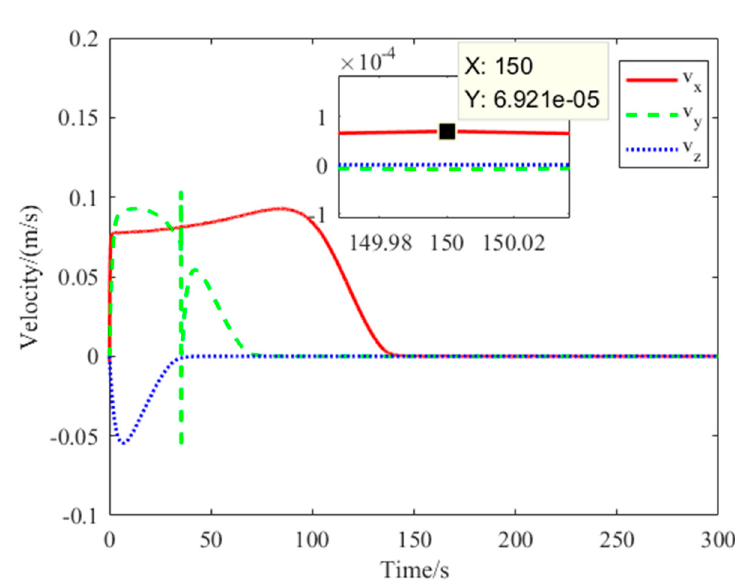
r - r   . Figure 8. Time response of velocity error . r − . r f f